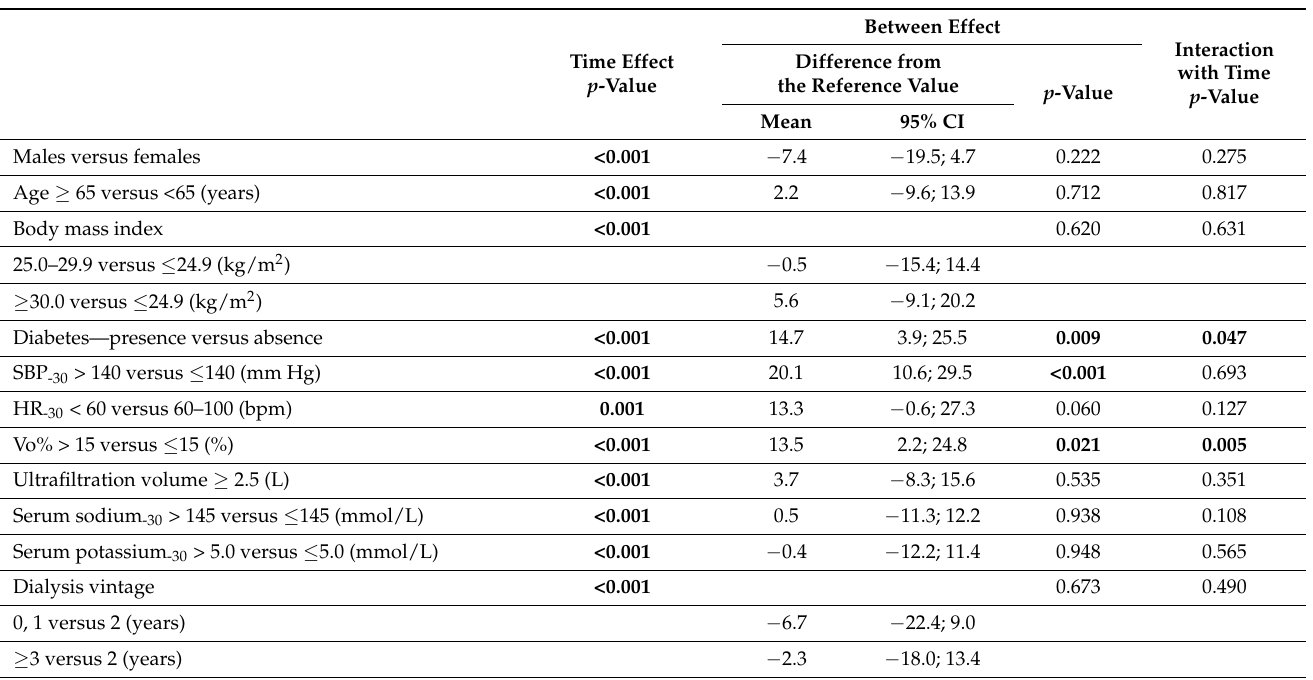
Table 6. Dynamics of pulse pressure during hemodialysis in relation to selected clinical and dialysis